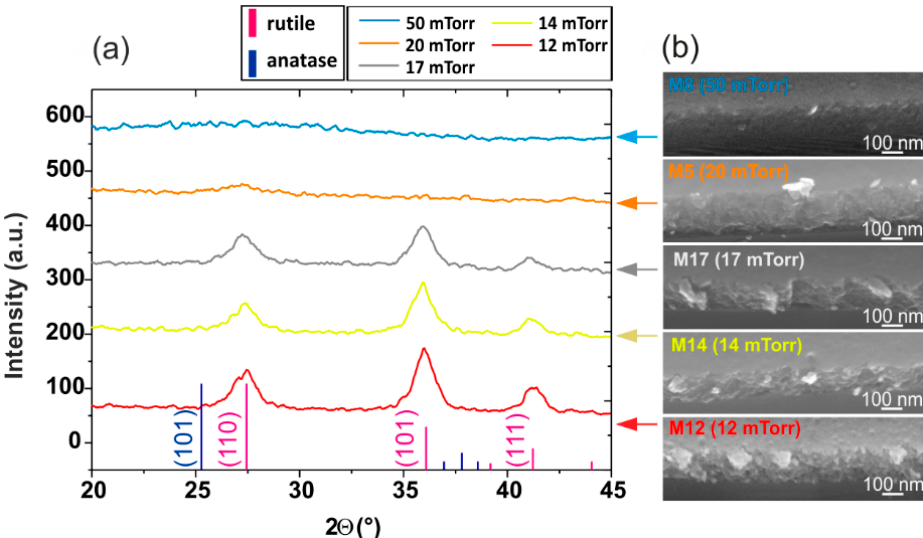
Figure 3. XRD pattern for four different pressures ( a ) with associated layer SEM images ( b ).